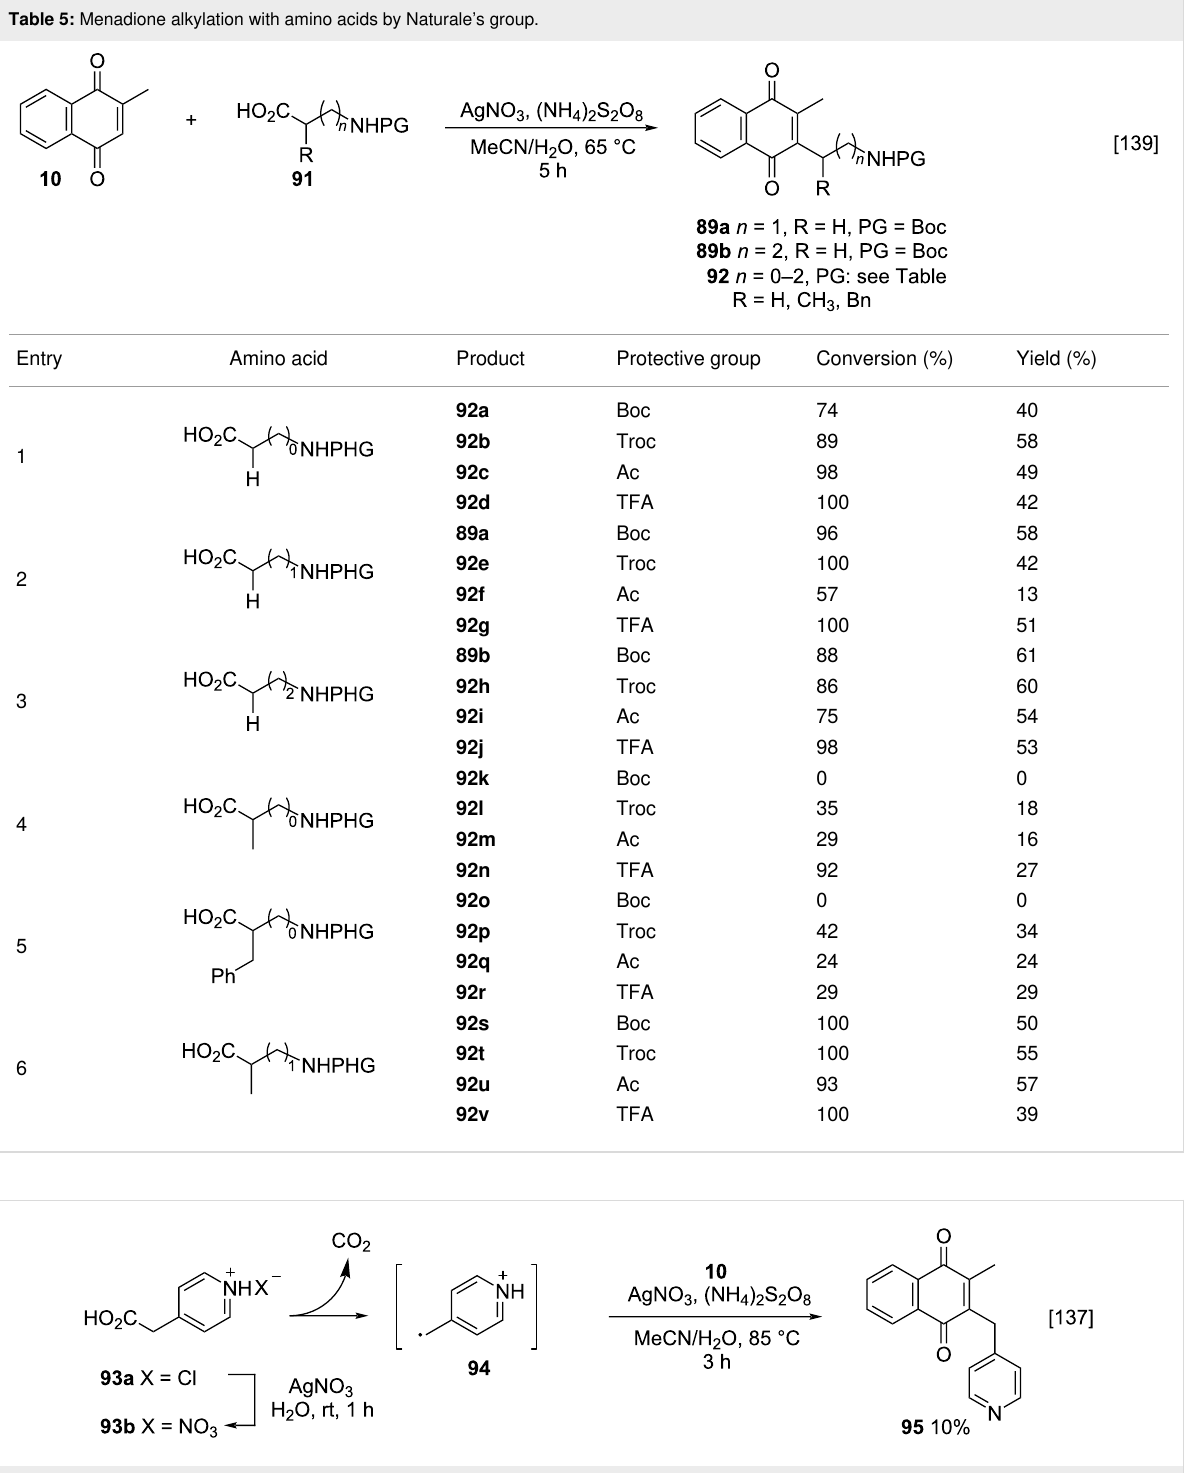
Scheme 31: Menadione alkylation by heterocycles-substituted carboxylic